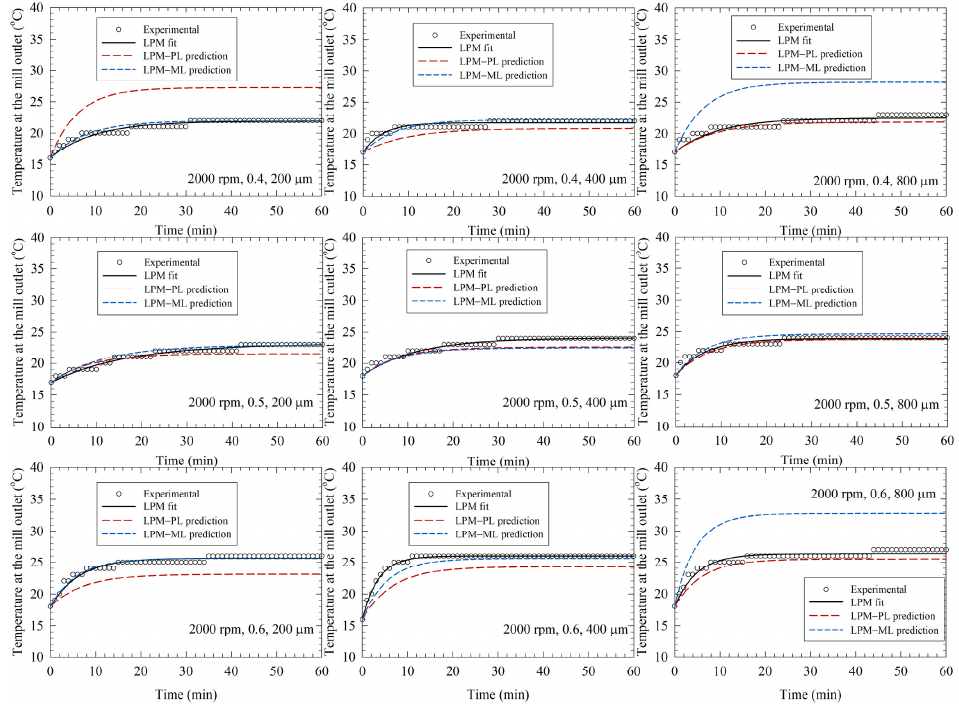
Figure 3. Experimental temperature profiles, direct fits by the lumped parameter model (LPM), and predictions by the LPM coupled with a power law (PL) model and a machine learning (ML) model. Left-to-right: increasing bead size, top-to-bottom: increasing bead loading, stirrer speed: 2000 rpm.